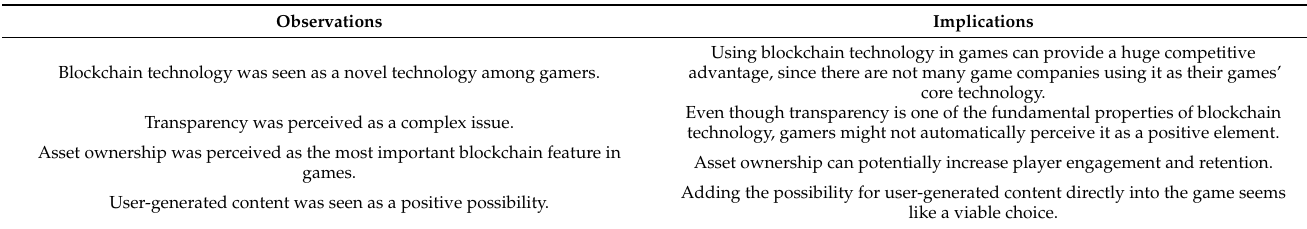
Table 6. Key observations from interviews and their